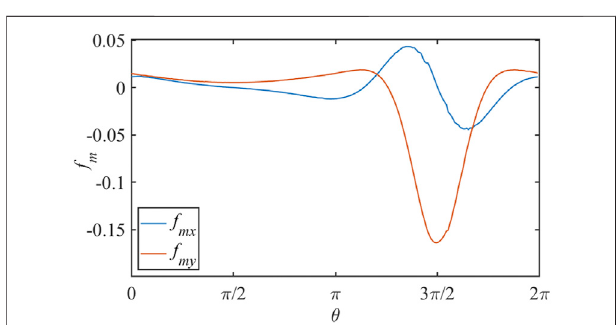
FIGURE 8 | Magnetic stress f m along the interface of the circular conducting